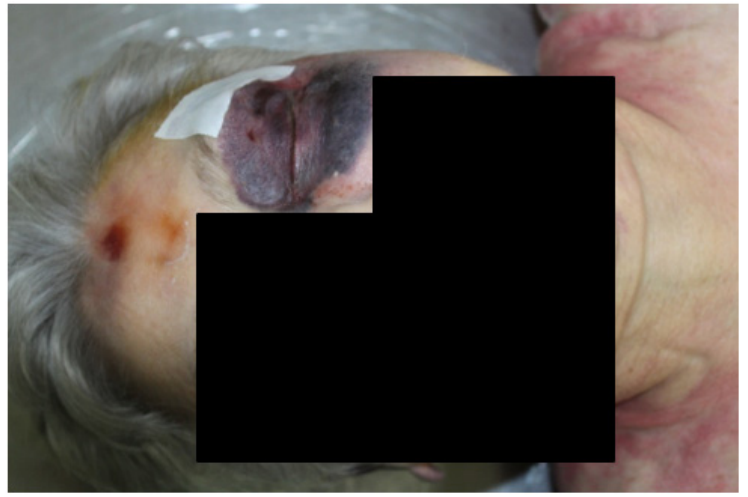
Figure 1. Facial trauma in case